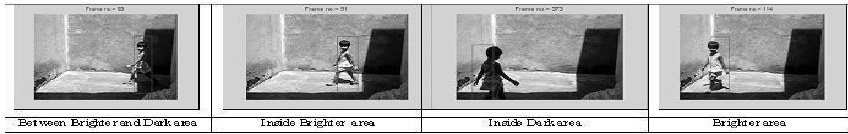
Figure 5. Video under different lighting condition.